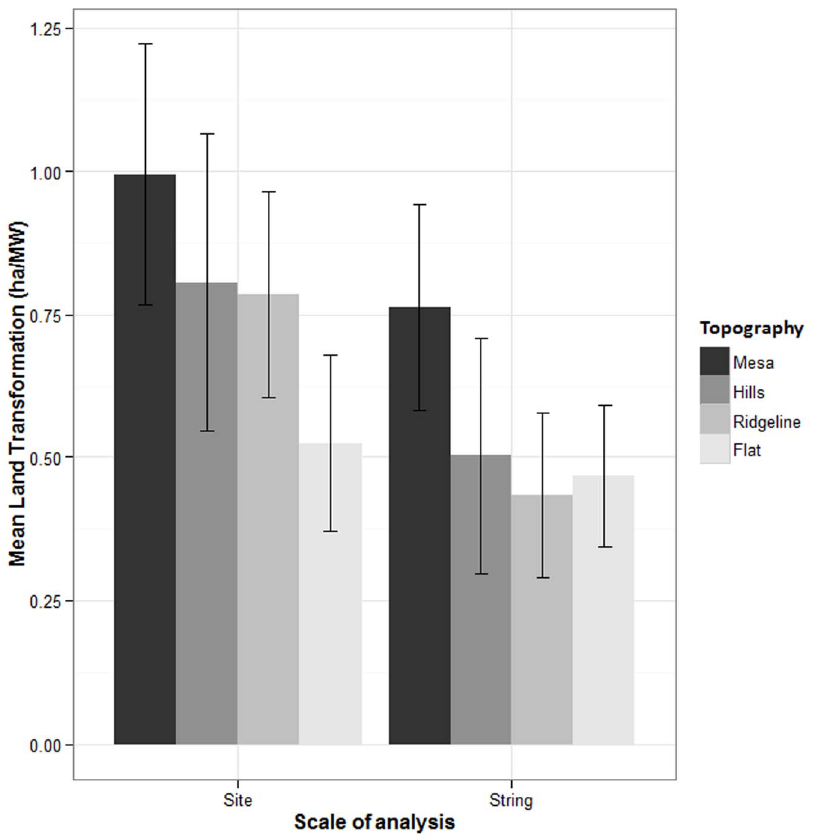
Figure 2. Mean ( ± 95% Confidence Interval) of the land transformation associated with wind facilities in different topographic categories at 2 spatial scales of analysis.